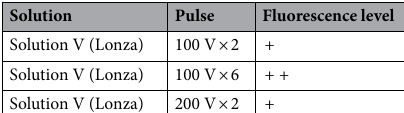
Table 2. Comparison of electroporation efficiency using the Lonza buffer and NEPA21 electroporator.